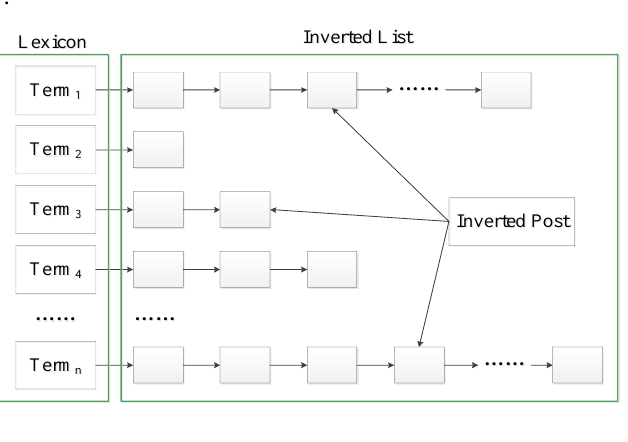
Figure 2. Inverted index structure